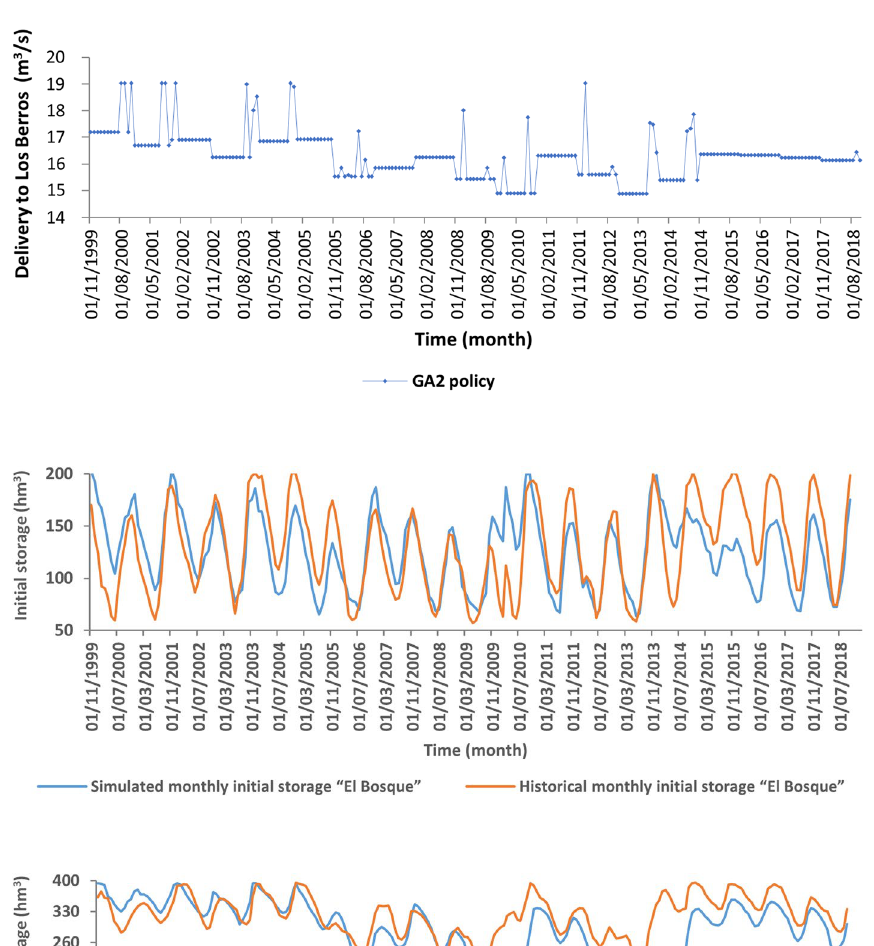
Fig. 7 The total monthly deliv‑ ery of water to the Los Berros water purification plant based on GA2 policy